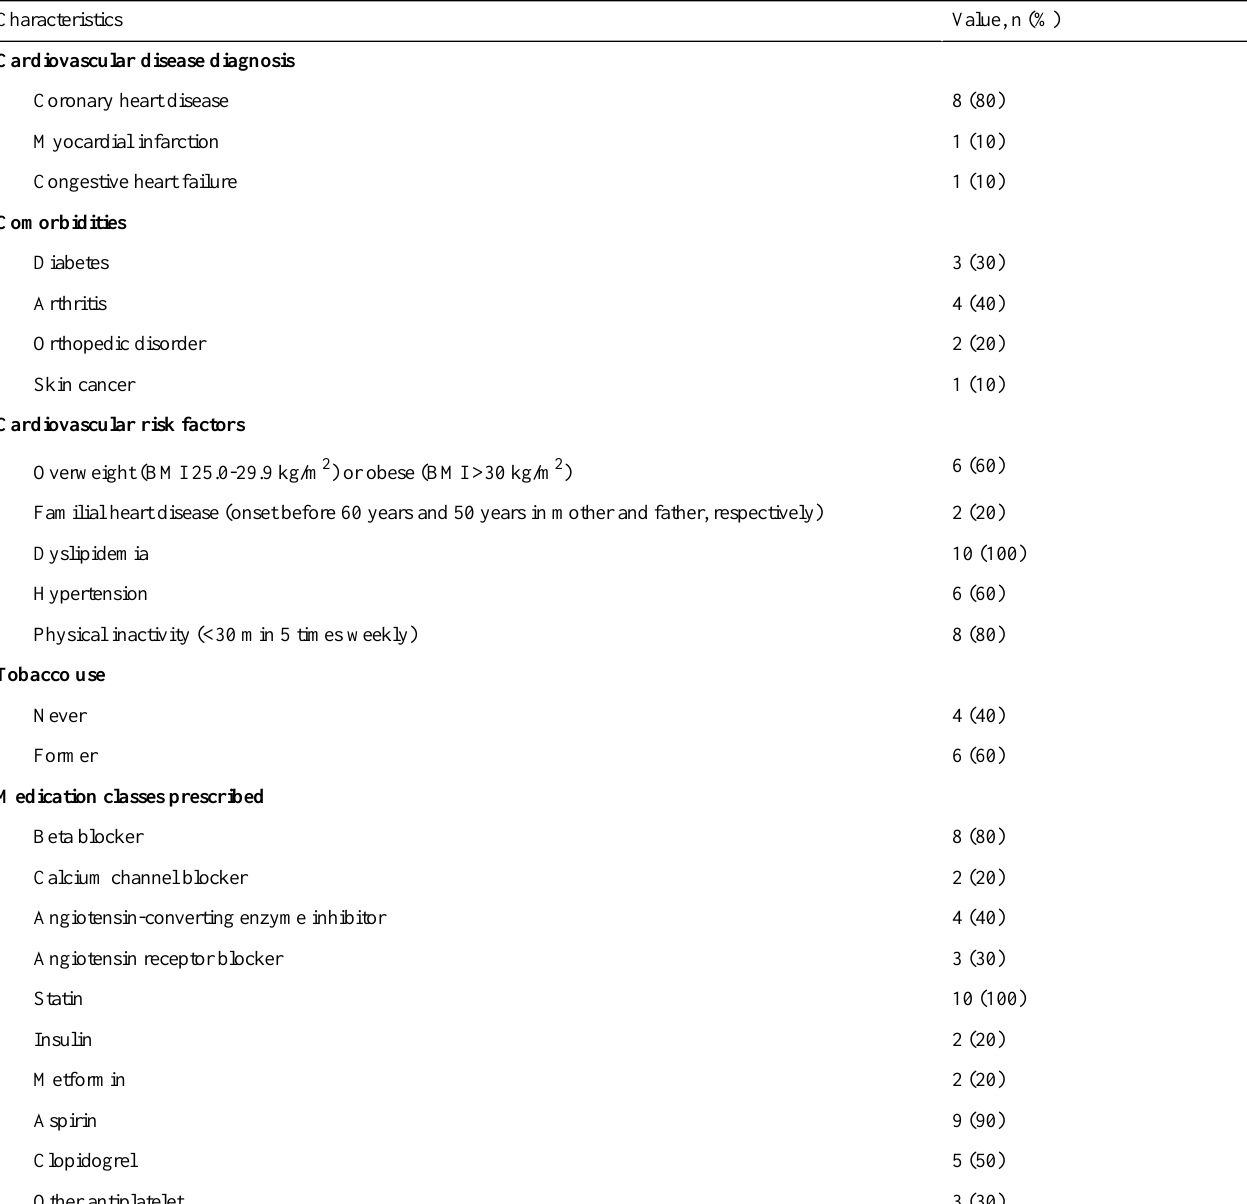
Table 2. Clinical characteristics of participants